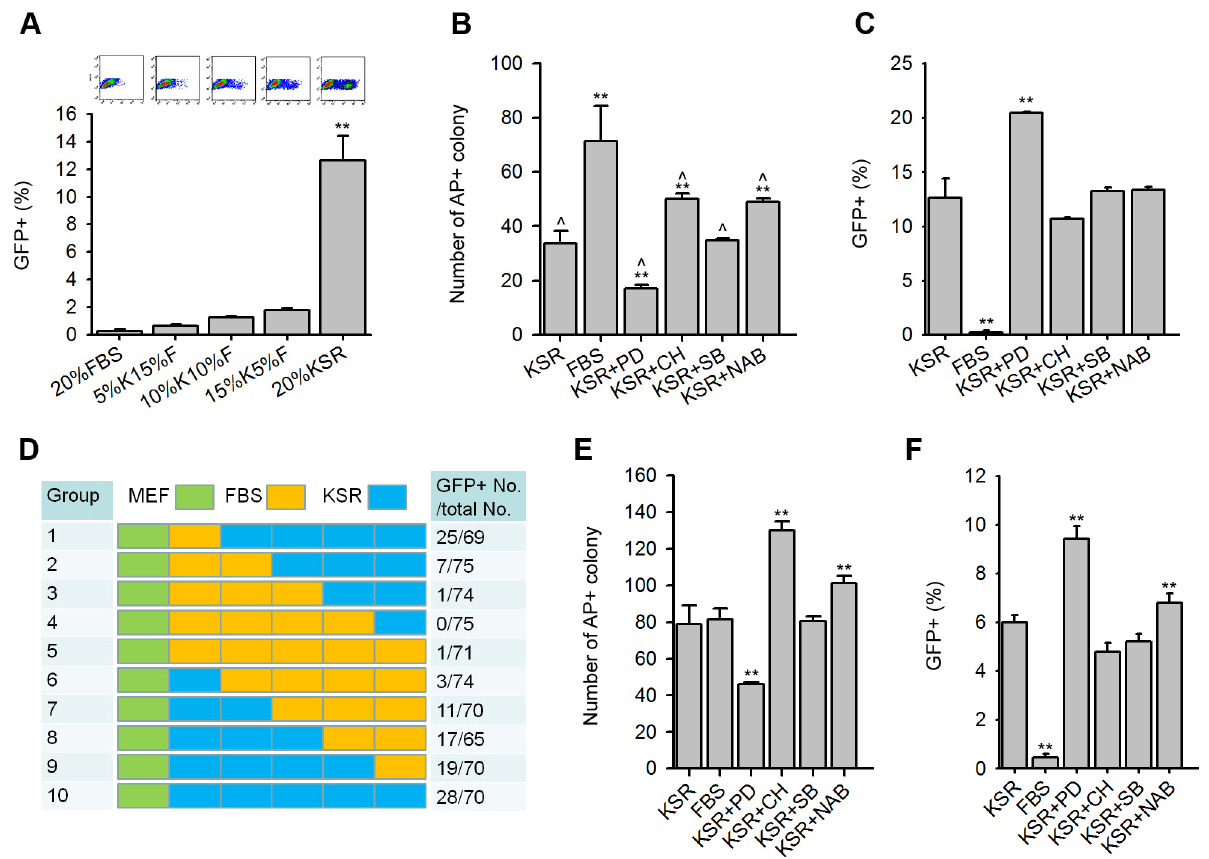
Figure 3. Effects of FBS and small molecules on reprogramming in KSR medium. (A–C) IPS cells derived from MEFs. Representative FACS images (upper) and the percentage of Nanog-GFP + cells by FACS analysis (lower) in different FBS/KSR ratio media on day 12 post-infection (A). AP + colony number (B) and the percentage of Nanog-GFP + cells (C) in different induction media on day 12. Induction media were KSR, FBS, or KSR based media with different small molecules (PD, CH, SB, and NAB, respectively). (D–F) IPS cells derived from adult fibroblasts. Schematic of the induction process for 12 days in different media series. There were 10 groups with different series of culture media. Each box represented 2 day period using indicated medium (MEF medium: green, KSR medium: blue, FBS medium: yellow). On day 3, the same number of infected fibroblasts were replated on new dishes using the appointed media. Cells were monitored and counted on day 12 (right column was Nanog-GFP + colony number/total colony number). The mean values were derived from three parallel experiments (D). AP + colony number (E) and the percentage of Nanog-GFP + cells (F) in different induction media on day 12 post-infection. ** represented significant differences between KSR and other conditions, ‘ represented significant differences between FBS and other conditions (P , 0.01).